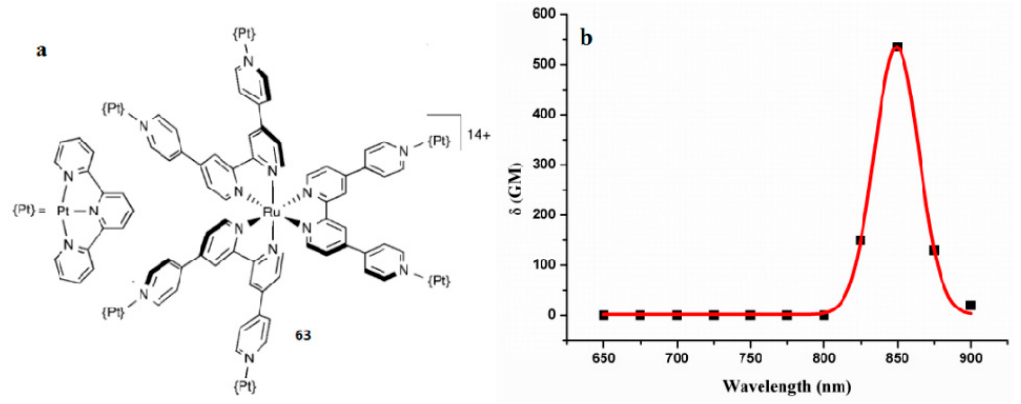
Figure 15. ( a ) Molecular structures of 62 ; ( b ) 2PA cross-sections of 62 in DMSO (dimethylsulphoxide) solution ( c = 1 × 10 − 3 mol · L − 1 ); ( c ) 2PFM of HepG2 cells co-labeled with 52 and Mitotracker.